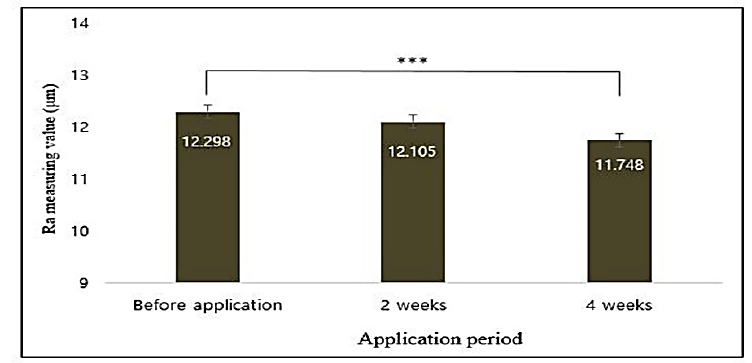
Figure 13. Correlation between application period of formulated cosmetics product and eye wrinkle average roughness values (Ra) analyzed using PRIMOS High Resolution. Data are given as mean ± SEM and statistical significance is shown by ANOVA (*** p < 0.001).